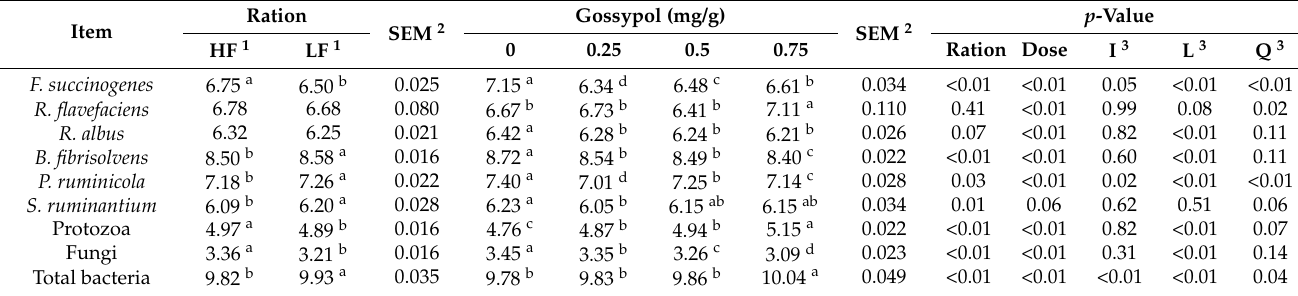
a,b,c,d Values in a line within the same class without a common superscript are significantly different ( p < 0.05). 1 HF, high-forage substrate; LF, low-forage substrate. 2 SEM, standard error of the difference of the means. 3 I, interaction effect; L, linear; Q,